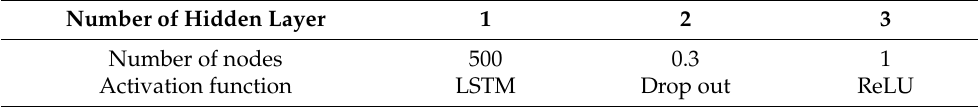
Table 10. The structure of the LSTM model for clouds and PM prediction.